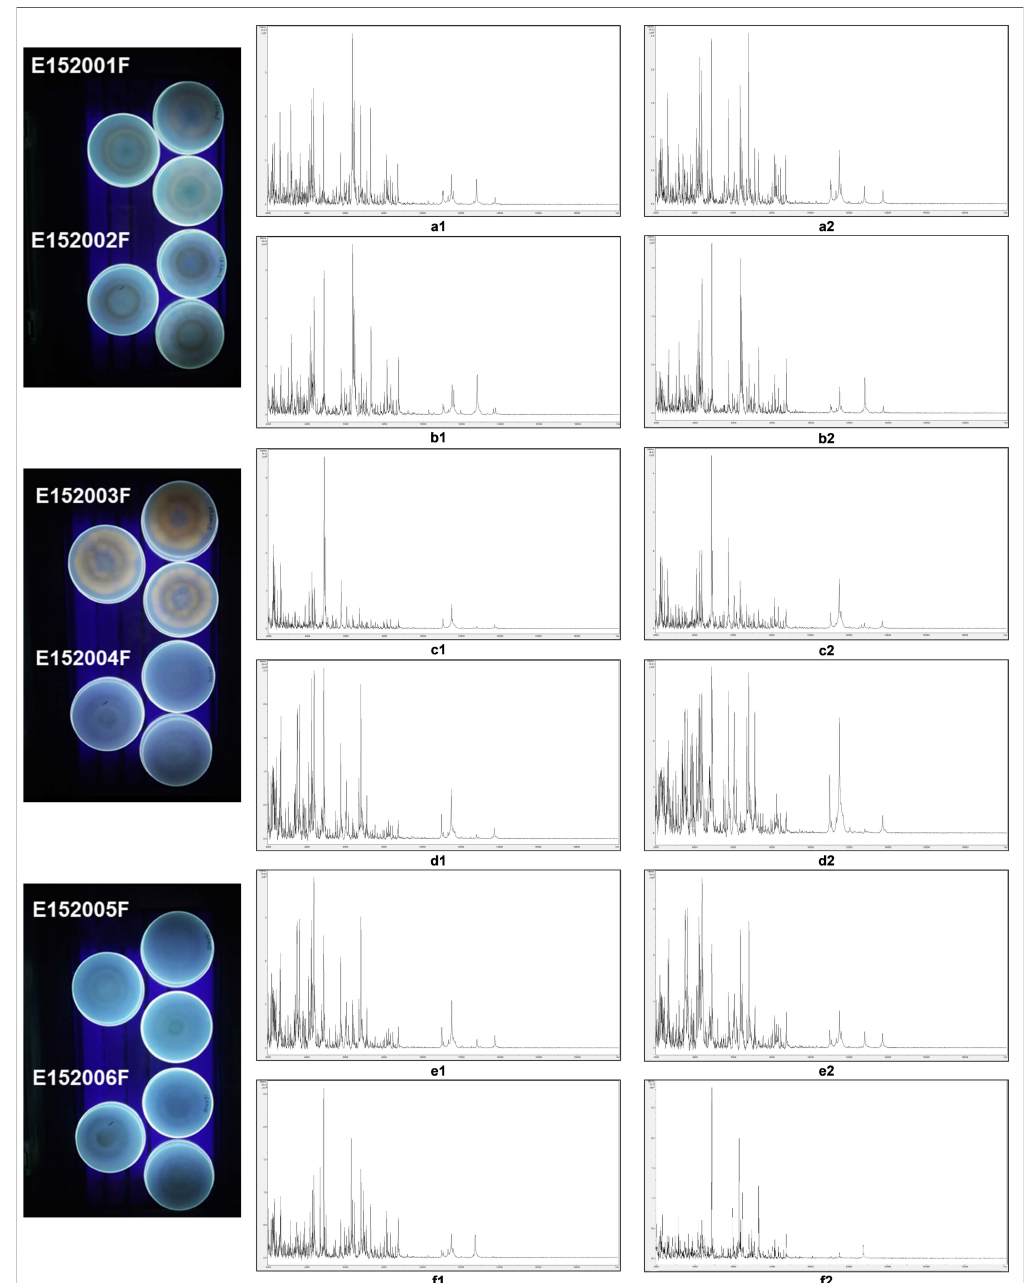
Figure 3. Visualization of coconut medium test under UV light, and the MALDI-ToF-MS duplicate spectra of putative Aspergillus flavus strains E152 (001F-006F): E152001F (a1, a2), E152002F (b1, b2), E152003F (c1, c2), E152004F (d1, d2), E152005F (e1, e2), E152006F (f1, f2). Duplicate spectra are shown baseline-subtracted, smoothed, y-axis-autoscaled, and covering the mass range 2 kDa to 20 kDa (with x-axis scale increments of 2 kDa). (Duplicate spectral profiles (from separate extractions ‘1 (cid:48) and ‘2 (cid:48) ) are shown for each isolate, a–f. Further information may be found in the Supplementary